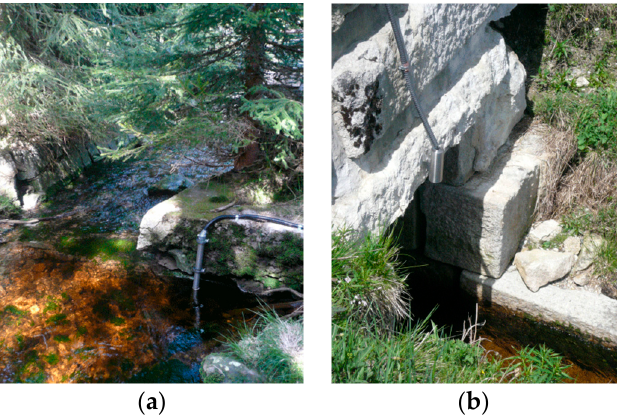
Figure 2. Water level sensors: ( a ) Hydrostatic pressure gauge fixed to the bottom of a montane creek; and ( b ) ultrasonic water level sensor fixed to the top of a dam culvert. Photo by Jakub Langhammer.